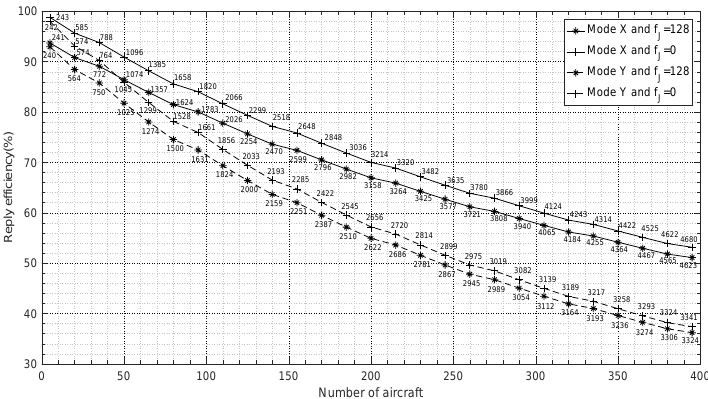
Figure 6. Reply efficiency in different modes vs. number of